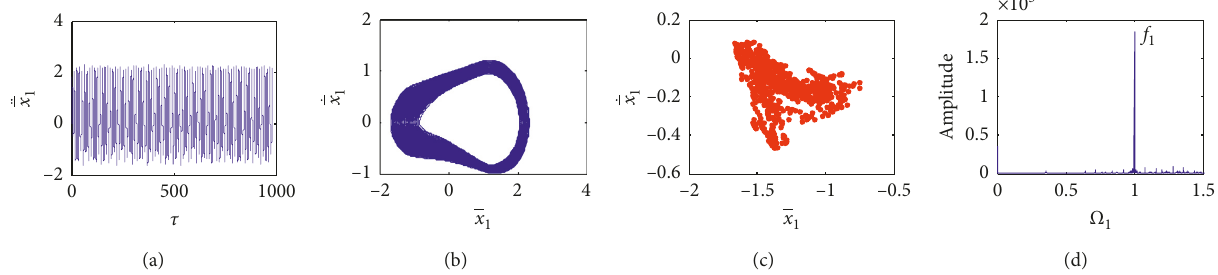
Figure 4: Vibration characteristics when Ω –505